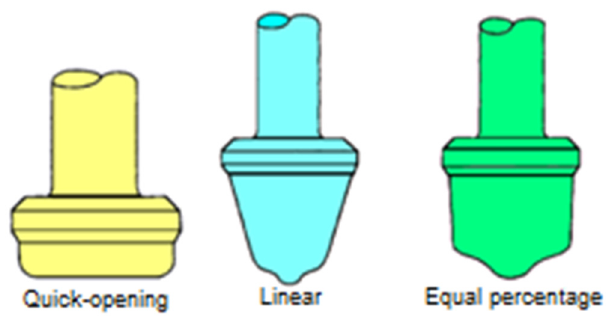
Figure 3. Plug types [7].